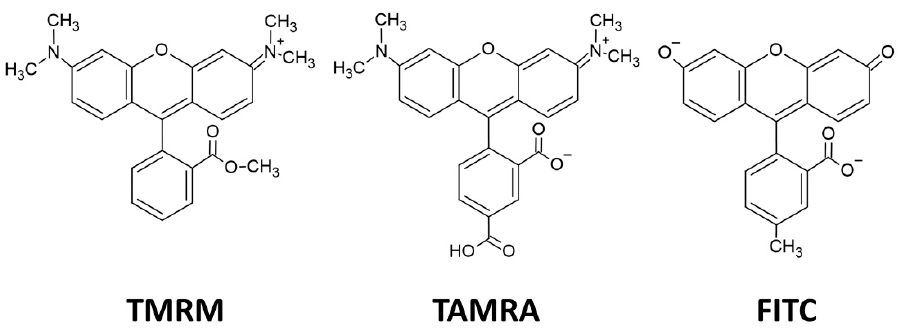
Figure 1. Structures of charged fluorescent molecules used in this study. Tetramethylrhodamine methyl ester (TMRM) has a net charge of +1, 5-carboxytetramethylrhodamine (TAMRA) has a net charge of 0, and fluorescein (FITC) has a net charge of -2.